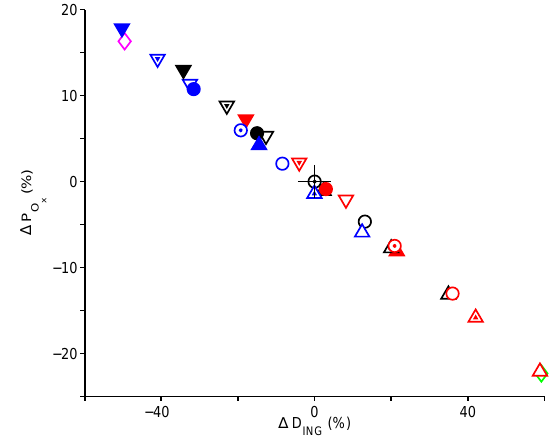
Fig. 4. The correlation between D ING and P O on the regional x scale (South America) across a large range of representations of ING chemistry suggests that the influence of ING chemistry on P O is primarily controlled by its net impact on NO x . Upward- x pointing triangles/Circles/downward-pointing triangles denote dif- ferent ING 0 yields: Y = 5%/10%/15%; red/black/blue colors refer to fast/medium/slow ING deposition; empty/half filled/filled sym- bols denote different NO x recycling from the photooxidation of ING 0 : α = 0/50/100%. The reference simulation is indicated by a vertical cross. The purple diamond indicates a simulation where the yield of ING 0 from ISOPO 2 + NO is set to zero. The green di- amond indicates a simulation where ING 0 , ING 1 and ING 2 have no photochemical sink (similar to the standard GEOS-Chem mech-